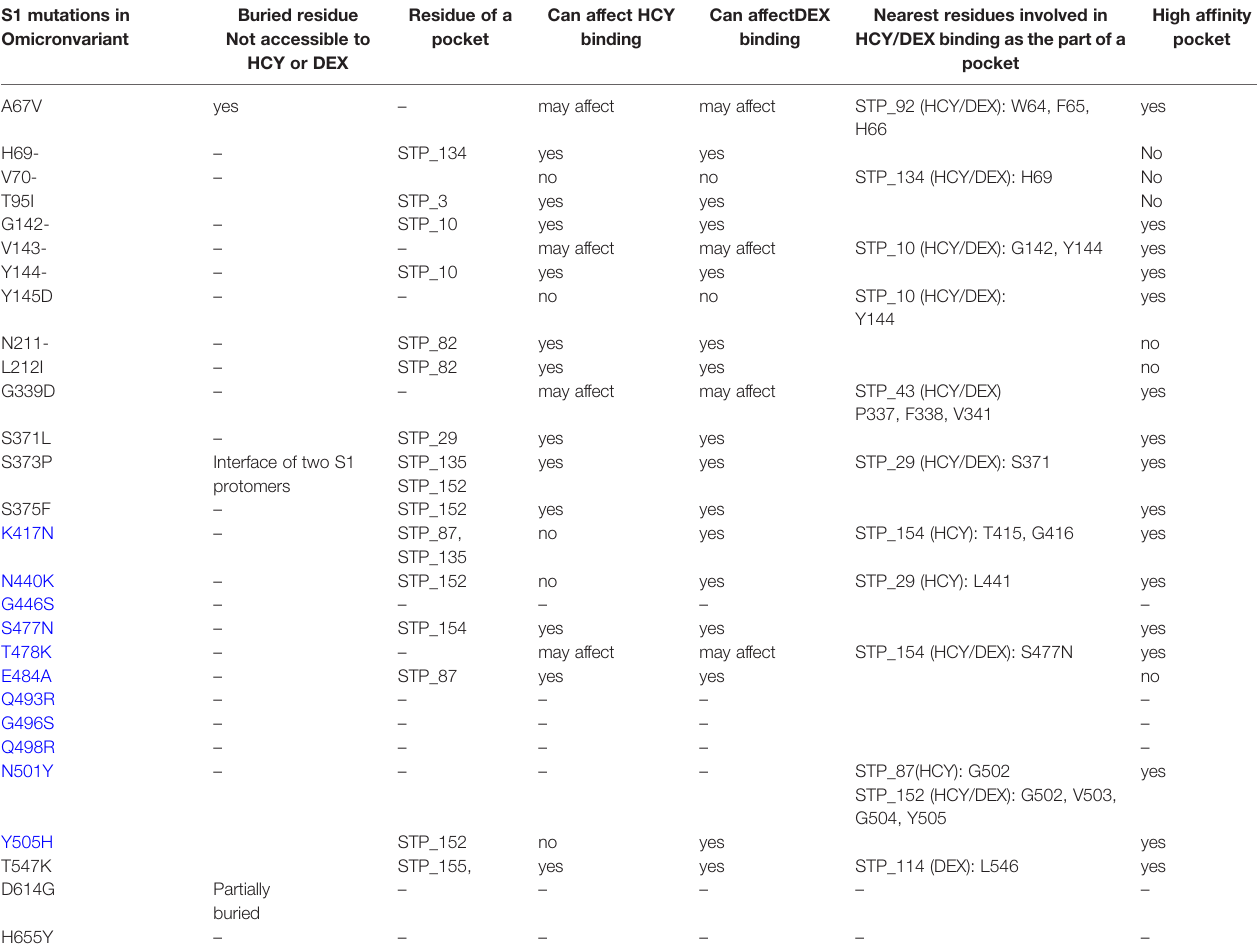
TABLE 6 | S1 mutations in Omicron variant (1.1.529) of SARS-CoV-2 and their accessibility to cortisol (HCY) and dexamethasone (DEX) binding. S1 mutations in